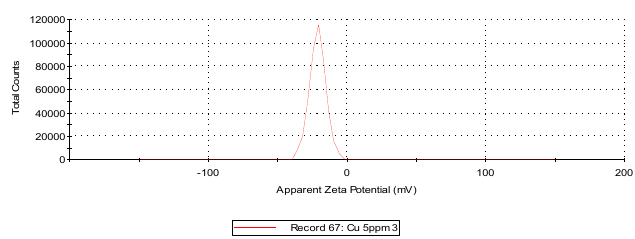
Figure 7. Representative distribution of zeta potential of CuNPs at a concentration of 5 mg/L.